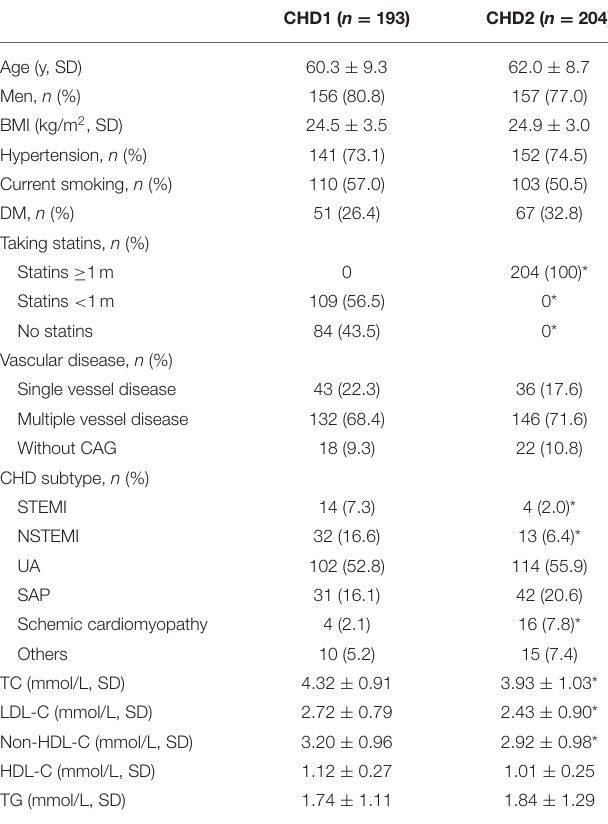
TABLE 1 | Baseline characteristics of the study